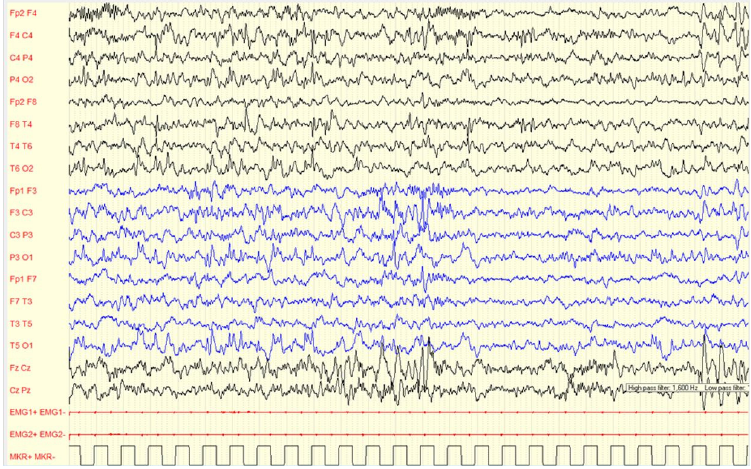
Figure 5. Female, 2 years-11 months, PSG (2–3 non-REM sleep): asynchronous sharp waves on right central-temporal and left frontal regions are showed. The background activity is characterized by excessive fast activity mainly over anterior areas, asynchronous sleep spindles.